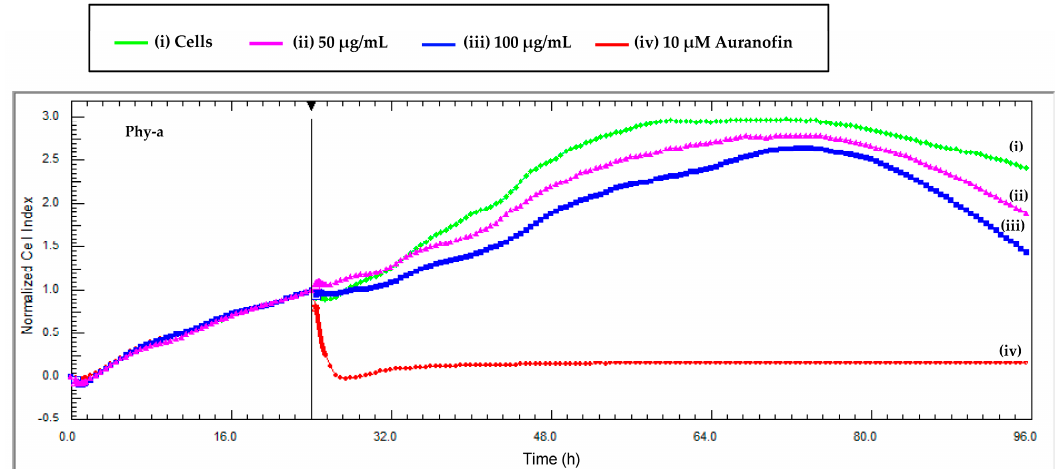
Figure 5. Real time cytotoxicity monitoring of phy-a on TZM-bl cells. The cells were seeded at 10,000 cells per well and were exposed to two concentrations of the compound at 24 h when the cell index was ±1. (i) A control of untreated cells was included and (iv) auranofin, a positive control for cytotoxicity. Each data point was calculated from duplicate values normalized against the time just before sample addition. Phy-a demonstrated low cytotoxicity towards TZM-bl at both concentrations tested, 50 and 100 μ g/mL (57 and 115 μ M).